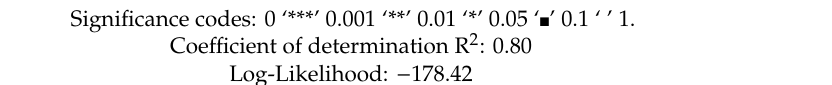
Table 4. Outcomes of the logistic regression model.